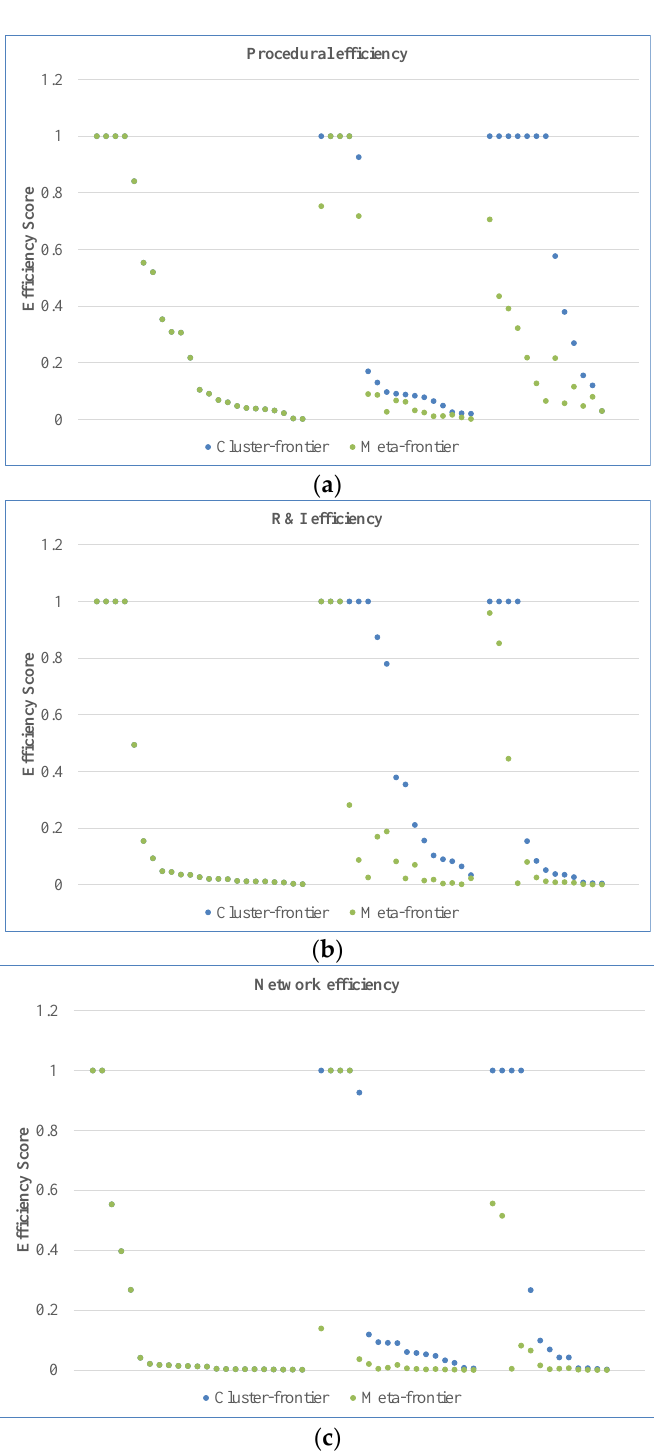
Figure 2. Efficiency scores of 53 OPs on meta- and cluster-frontiers for cluster- and meta frontier for Procedural efficiency ( a ), R&I potential capacity ( b ) and overall network efficiency ( c ). Note: Efficiency scores are presented from the left to the right for the more developed, transition and less developed regions, respectively.